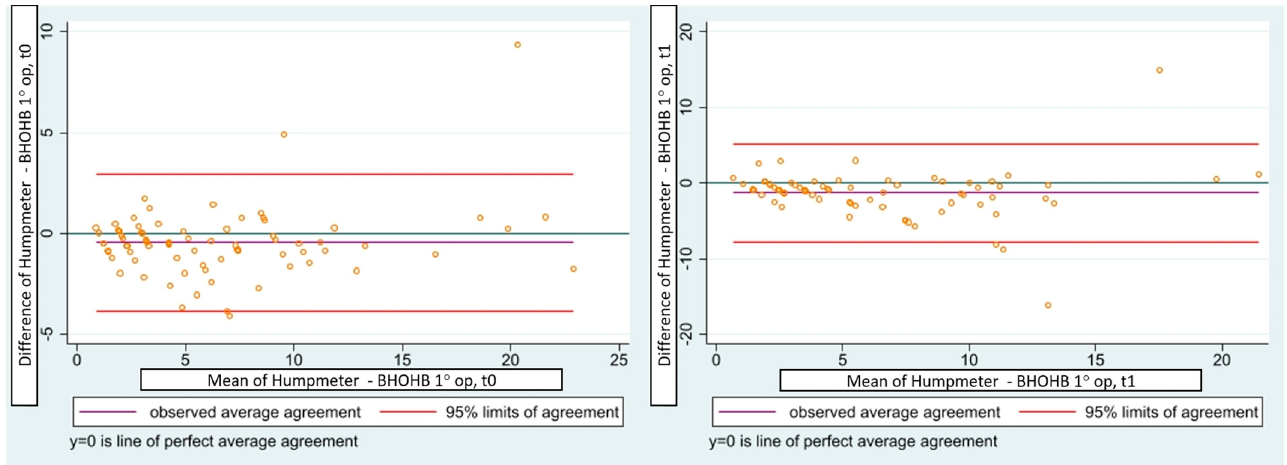
Figure 7. Concordance correlation confidence (Lin 1989–2000) between the humpmeter and BHOHB in t0 and t1. in t0 and